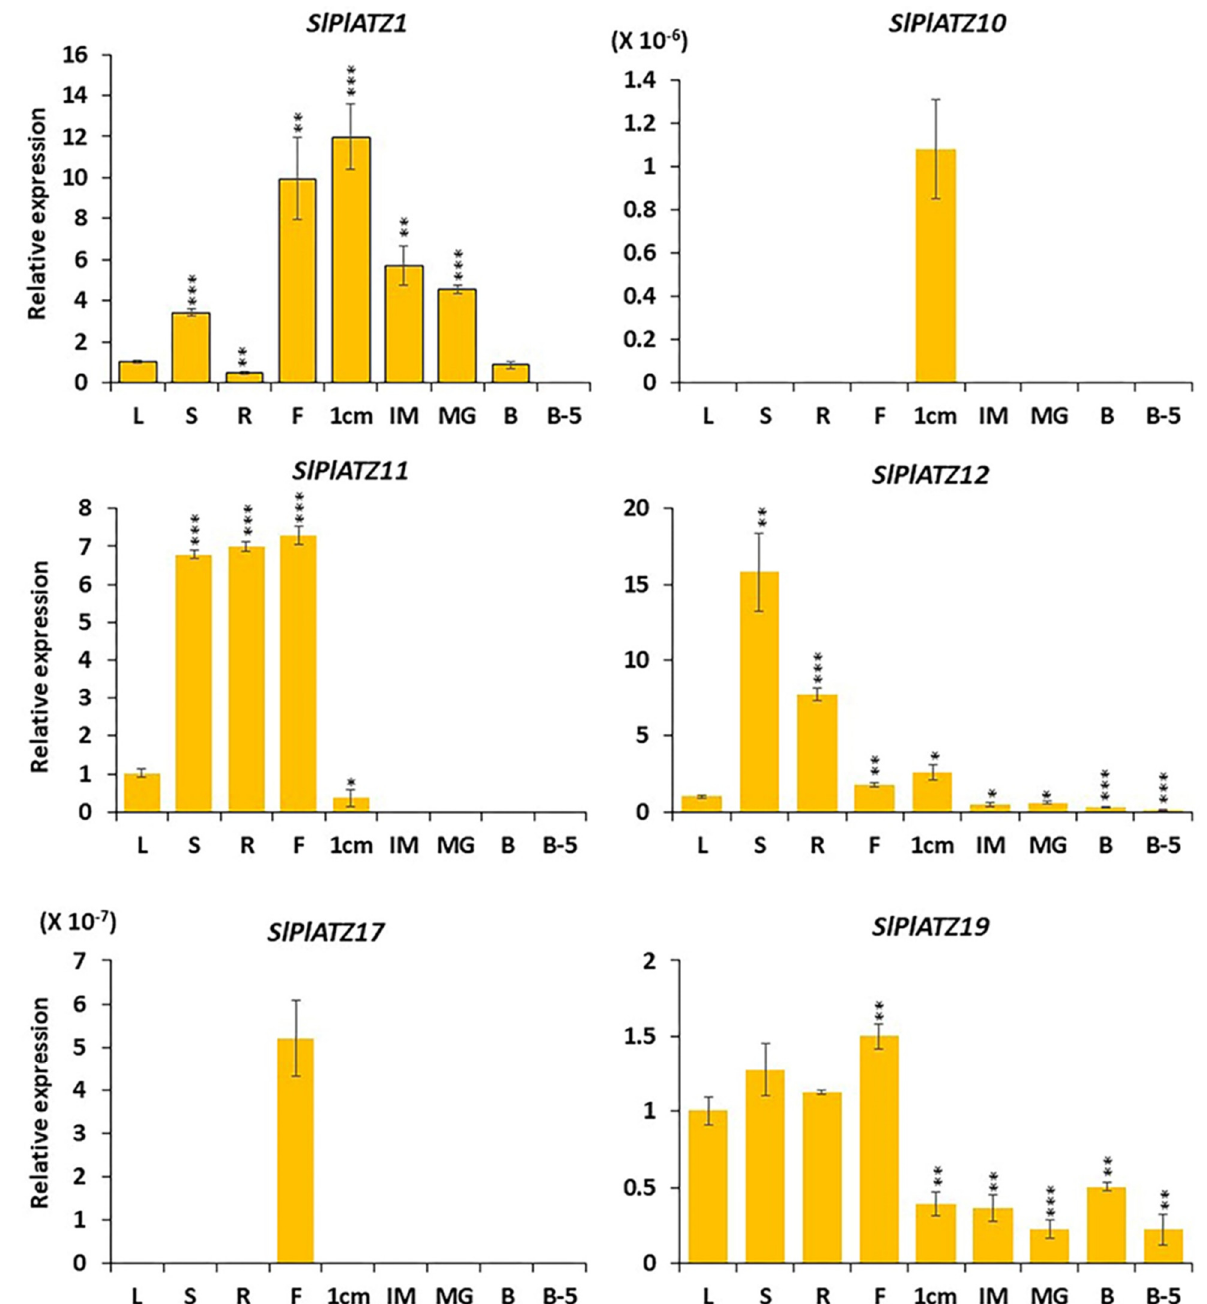
Figure 6. qRT − PCR expression analysis of SlPLATZ genes in various organs. The organs used for the expression analysis are leaves (L), roots (R), stems (S), flowers (F), 1 cm fruits (1 cm), immature fruits (IM), mature green fruits (MG), breaker fruits (B), and fruits 5 days after breaker stage (B5). Error bars indicate the standard deviations of the means of three independent biological replicates. *, **, and *** represent the significant difference between the control samples (leaves) and the samples from the other organs according to Student’s t − test, at p − values <0.05, <0.01, and <0.001, respectively.